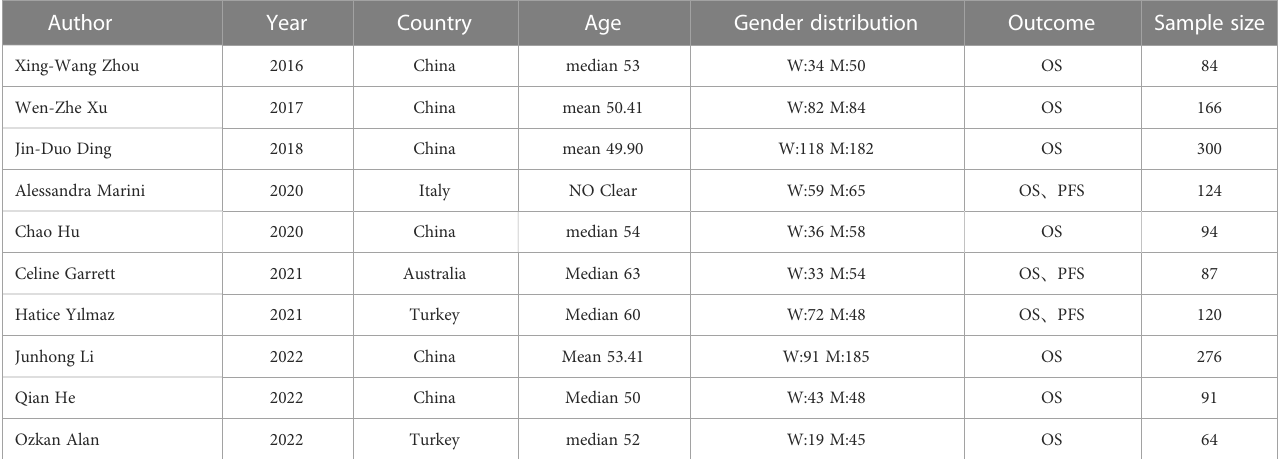
TABLE 1 Summary of characteristics of the included studies.